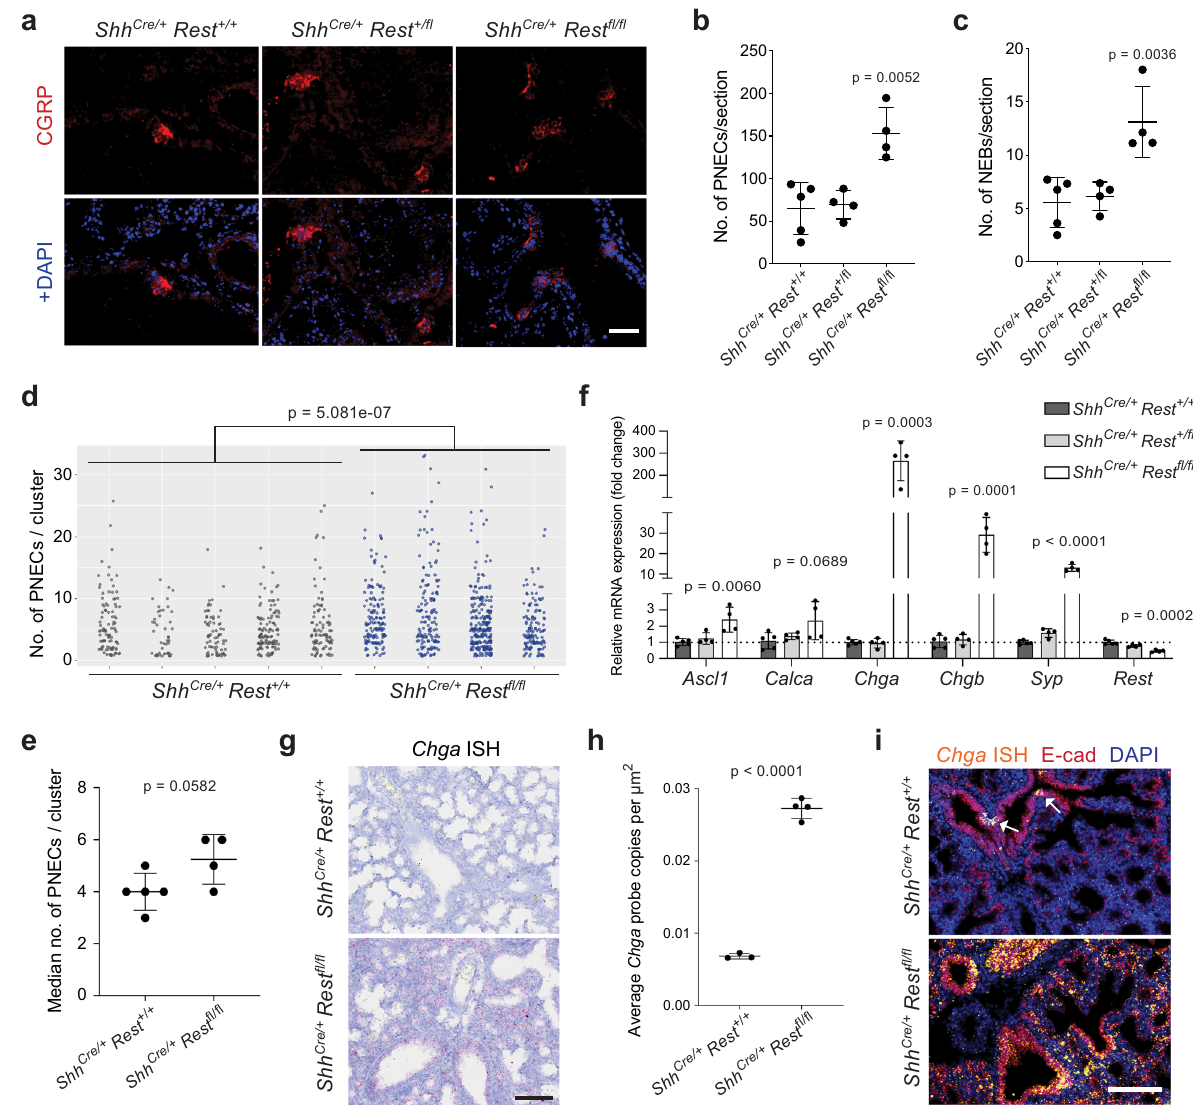
Fig. 5 REST is antagonistic to pulmonary neuroendocrine cells speci fi cation in normal lung development. a Immunostaining for CGRP, a marker of pulmonary neuroendocrine cells (PNECs) on sections from E18.5 Shh cre/ + ; Rest + / + , Rest + / fl , and Rest fl / fl lungs. DAPI stains DNA in blue. Scale bar, 50 μ m. b – d Quanti fi cation of the average number of CGRP + PNECs ( b ) and neuroepithelial bodies (NEBs) ( ≥ 5 PNECs) ( c ) per lung section from each embryo ( n = 5 embryos with 37 sections counted for Rest + / + and 4 embryos with 30 sections counted for Rest + / fl and Rest fl / fl ). Unpaired t-test, data represented as mean ± s.d. In ( d ), a scatterplot of all solitary PNECs and clusters of each embryo ( n = 438 for Rest + / + , 688 for Rest fl / fl ). Wilcoxon rank sum test, two- sided, on the combined data points of each genotype. e , Median number of PNECs per cluster for each embryo as in ( d ) ( n = 5 embryos for Rest + / + and 4 embryos for Rest fl / fl ). Unpaired t -test, data represented as mean ± s.d. f Relative mRNA expression levels of NE markers and Rest in E18.5 Shh cre/ + ; Rest + / + , Rest + / fl , and Rest fl / fl lungs ( n = 5 embryos for Rest + / + and 4 embryos for Rest + / fl and Rest fl / fl ). Unpaired t -test, data represented as mean ± s.d. g Representative bright fi eld images of Chga RNAscope in situ hybridization (ISH, red signal) in E18.5 Shh cre/ + ; Rest + / + and Rest fl / fl lungs (hematoxylin counterstain). Scale bar, 50 μ m. h Quanti fi cation of the average number of RNAscope signal per μ m 2 of lung section in ( g ) ( n = 3 embryos for Rest + / + and 4 embryos for Rest fl / fl ). Unpaired t -test, data represented as mean ± s.d. i , Representative images for Chga RNAscope ISH (orange) and E-cadherin immuno fl uorescence (red) in E18.5 Shh cre/ + ; Rest + / + and Rest fl / fl lungs. DAPI stains the DNA in blue. White arrows, NEBs. Scale bar, 100 μ m. See also Supplementary Fig. 8. Source data are provided as a Source Data fi le. Yap1 deletion prevents NE to non-NE transition after injury .